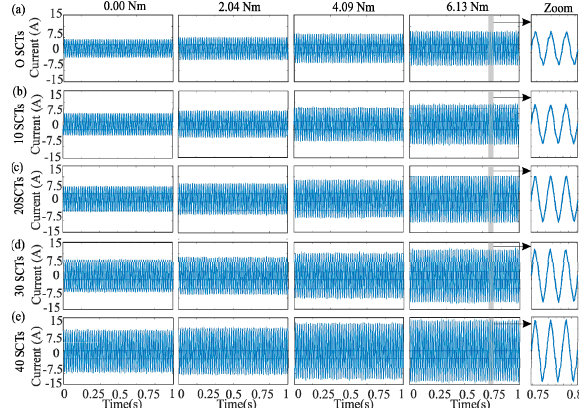
Figure 5. Current signals for ( a ) 0 SCTs, ( b ) 10 SCTs, ( c ) 30 SCTs and ( d ) 40 SCTs at different loads (0.00, 2.04, 4.09 and 6.13 Nm).